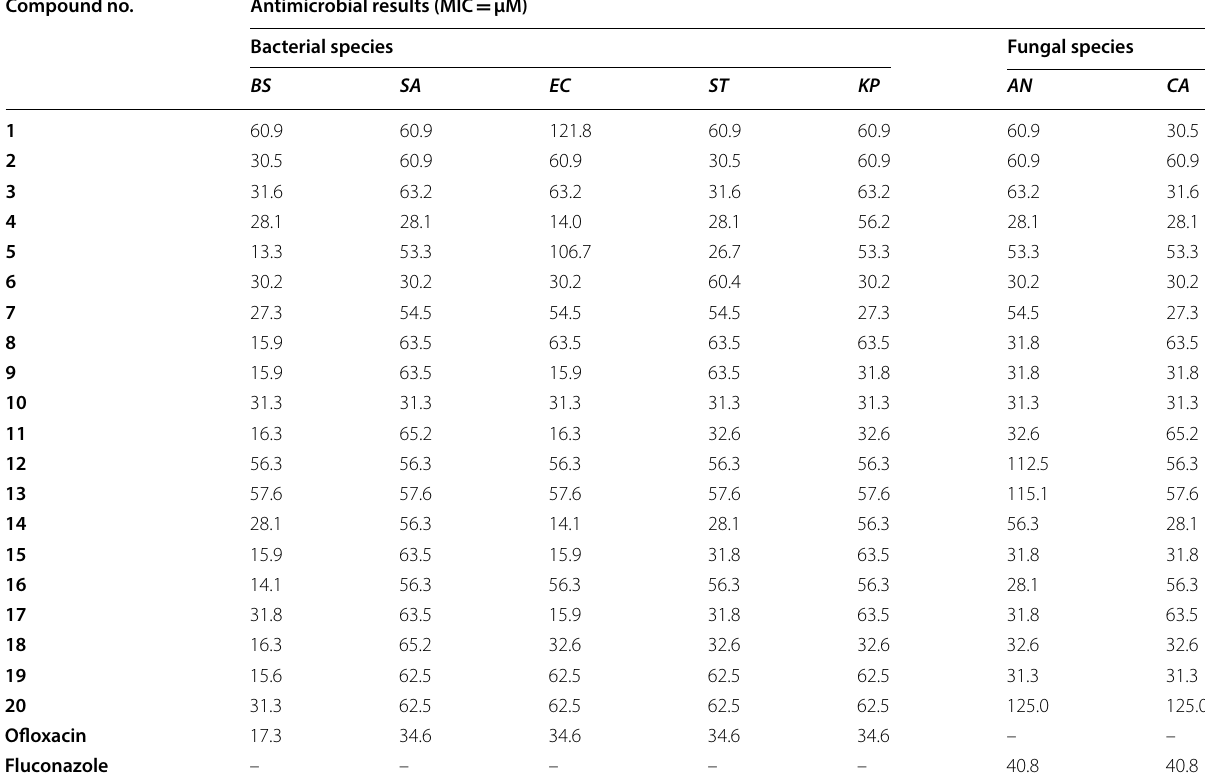
Table 3 In vitro antimicrobial activity of the synthesized compounds Compound no.